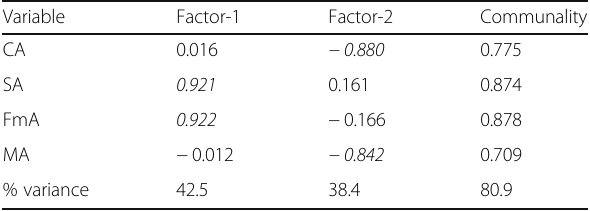
Table 2 Factor analysis of different organic